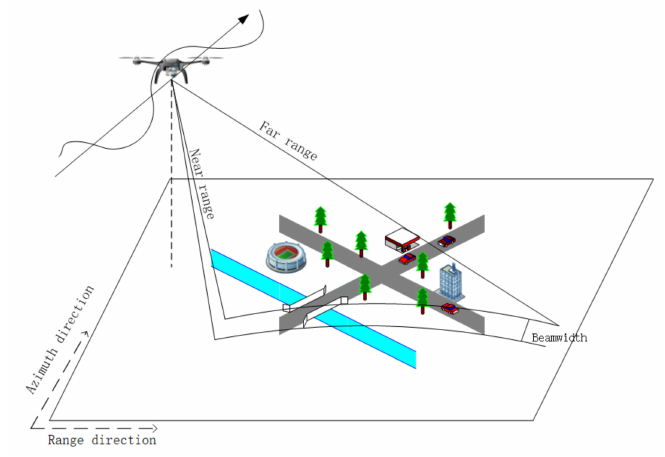
Figure 4. UAV-borne PolInSAR imaging geometry.